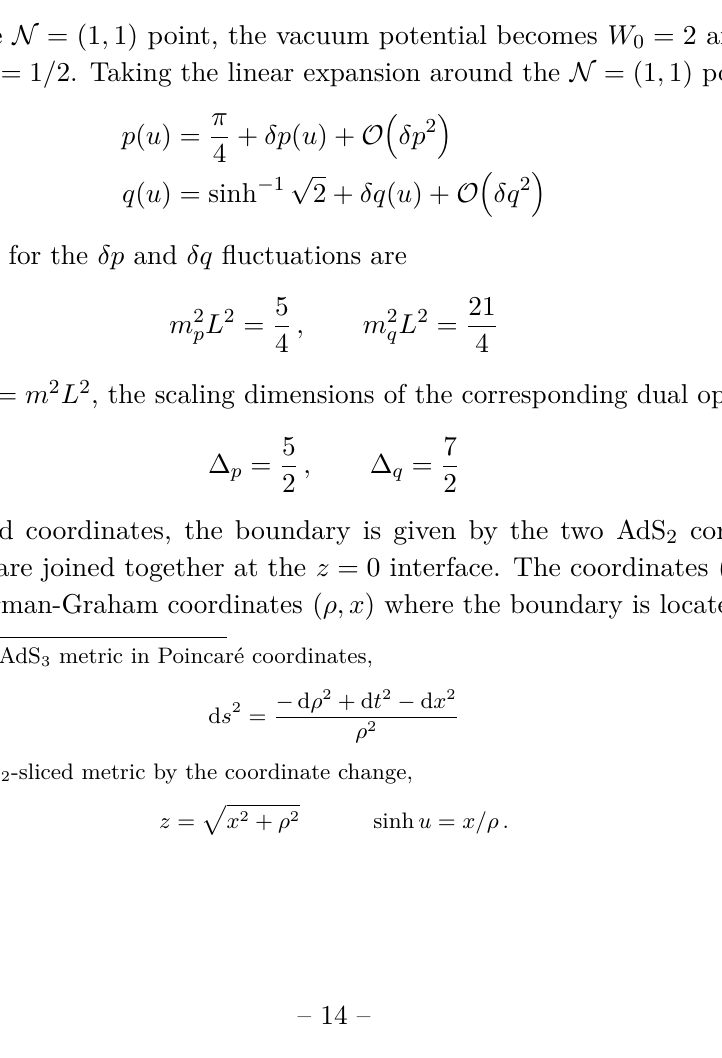
Figure 2 . (a) pq parametric plot, (b) plot of q , (c) plot of p , (d) plot of the metric function B as functions of the AdS slicing coordinate u 2